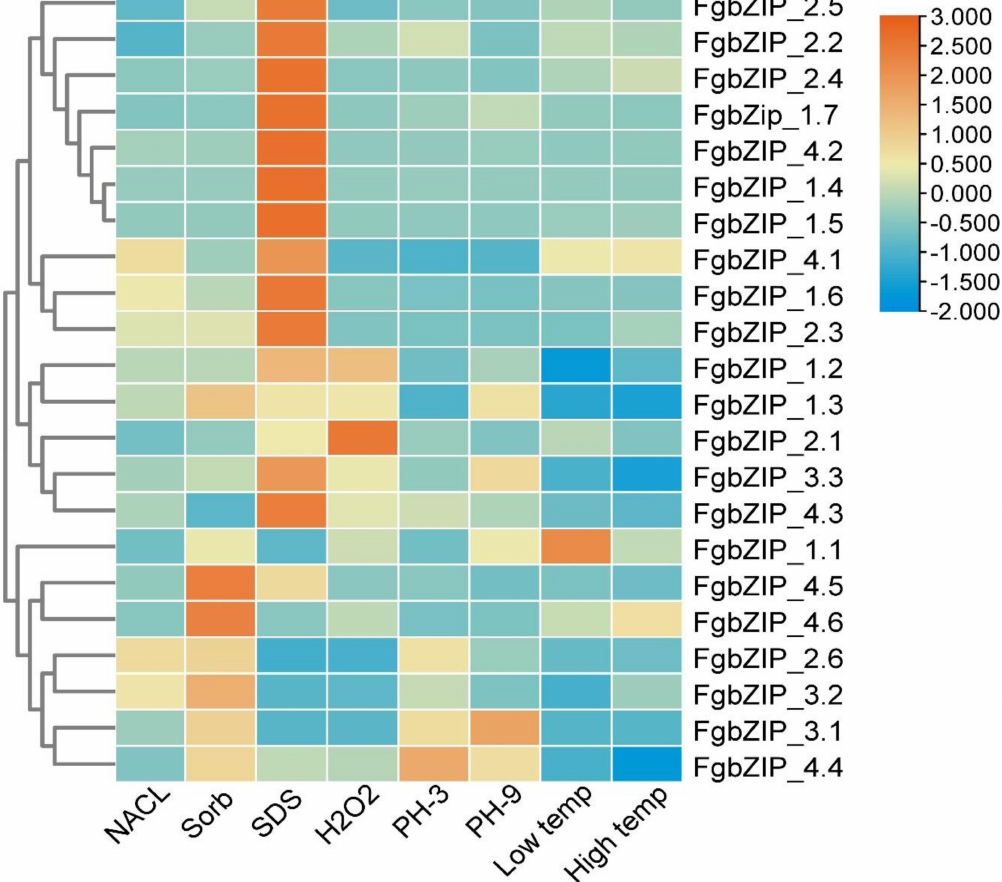
Figure 8. Expression profiles of FgbZIP genes response to abiotic stress. Relative expression values of RT_qPCR results were transformed by log2. Fold changes in gene expression are shown in color according to the scale. NaCl: sodium chloride, Sorb: Sorbitol, SDS: sodium dodecyl sulfate, H 2 O 2 : hydrogen peroxide, Low Temp: low temperature (4 ◦ C), High Temp: high temperature (37 ◦